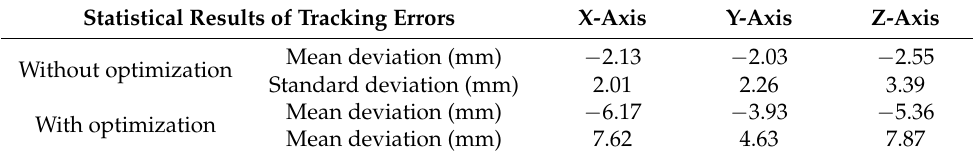
Figure 26. The tracking errors of the end effector in simulation. ( a ) Tracking error of X axis; ( b ) Track- ing error of Y axis; ( c ) Tracking error of X axis. Table 5. Statistical results of tracking errors in linear working path